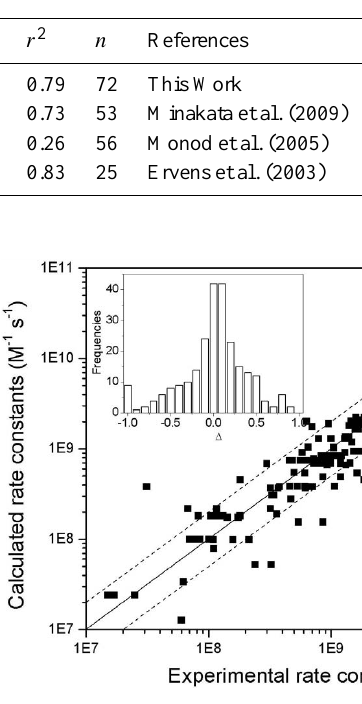
Figure 5: Correlation plot between experimental and calculated rate constants for all compounds: 2 Fig. 5. Correlation plot between experimental and calculated alkanes, alcohols, acids, bases, (Monod and Doussin (2008)), aldehydes, ketones (this work) and 3 rate constants for all compounds: alkanes, alcohols, acids, bases, polyfunctionals (both works). The plain line is the linear regression line y =1.008×x and the dashed 4 (Monod and Doussin, 2008), aldehydes, ketones (this work) and lines define the limits where the rate constants are calculated within a factor of 2 from the 5 experimental data. The inset is the distribution of the  factor (see equation 2) for the whole set of 6 polyfunctionals (both works). The plain line is the linear regression data. 7 line y =1.008 × x and the dashed lines define the limits where the 8 rate constants are calculated within a factor of 2 from the experi- mental data. The inset is the distribution of the 1 factor (see Eq. 2) for the whole data